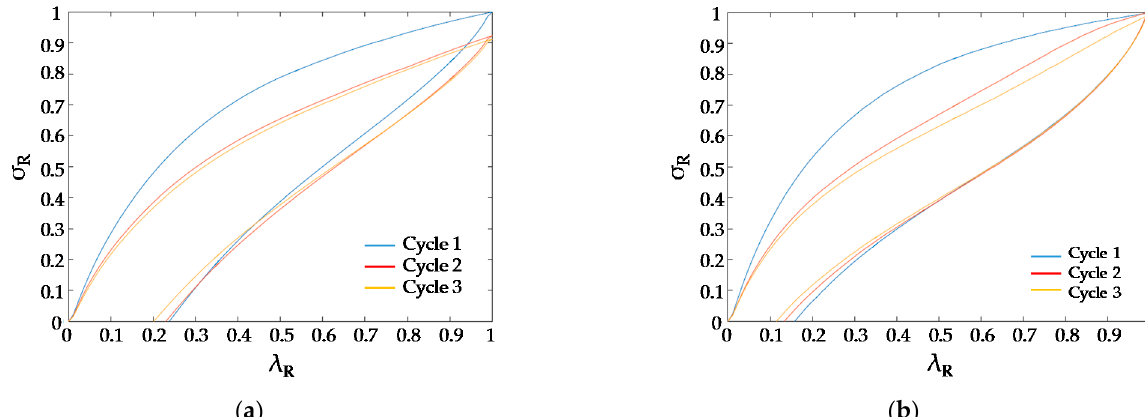
Figure 5. Stress–strain cycles. ( a ) For the feedstock filament; ( b ) for the extruded filament.